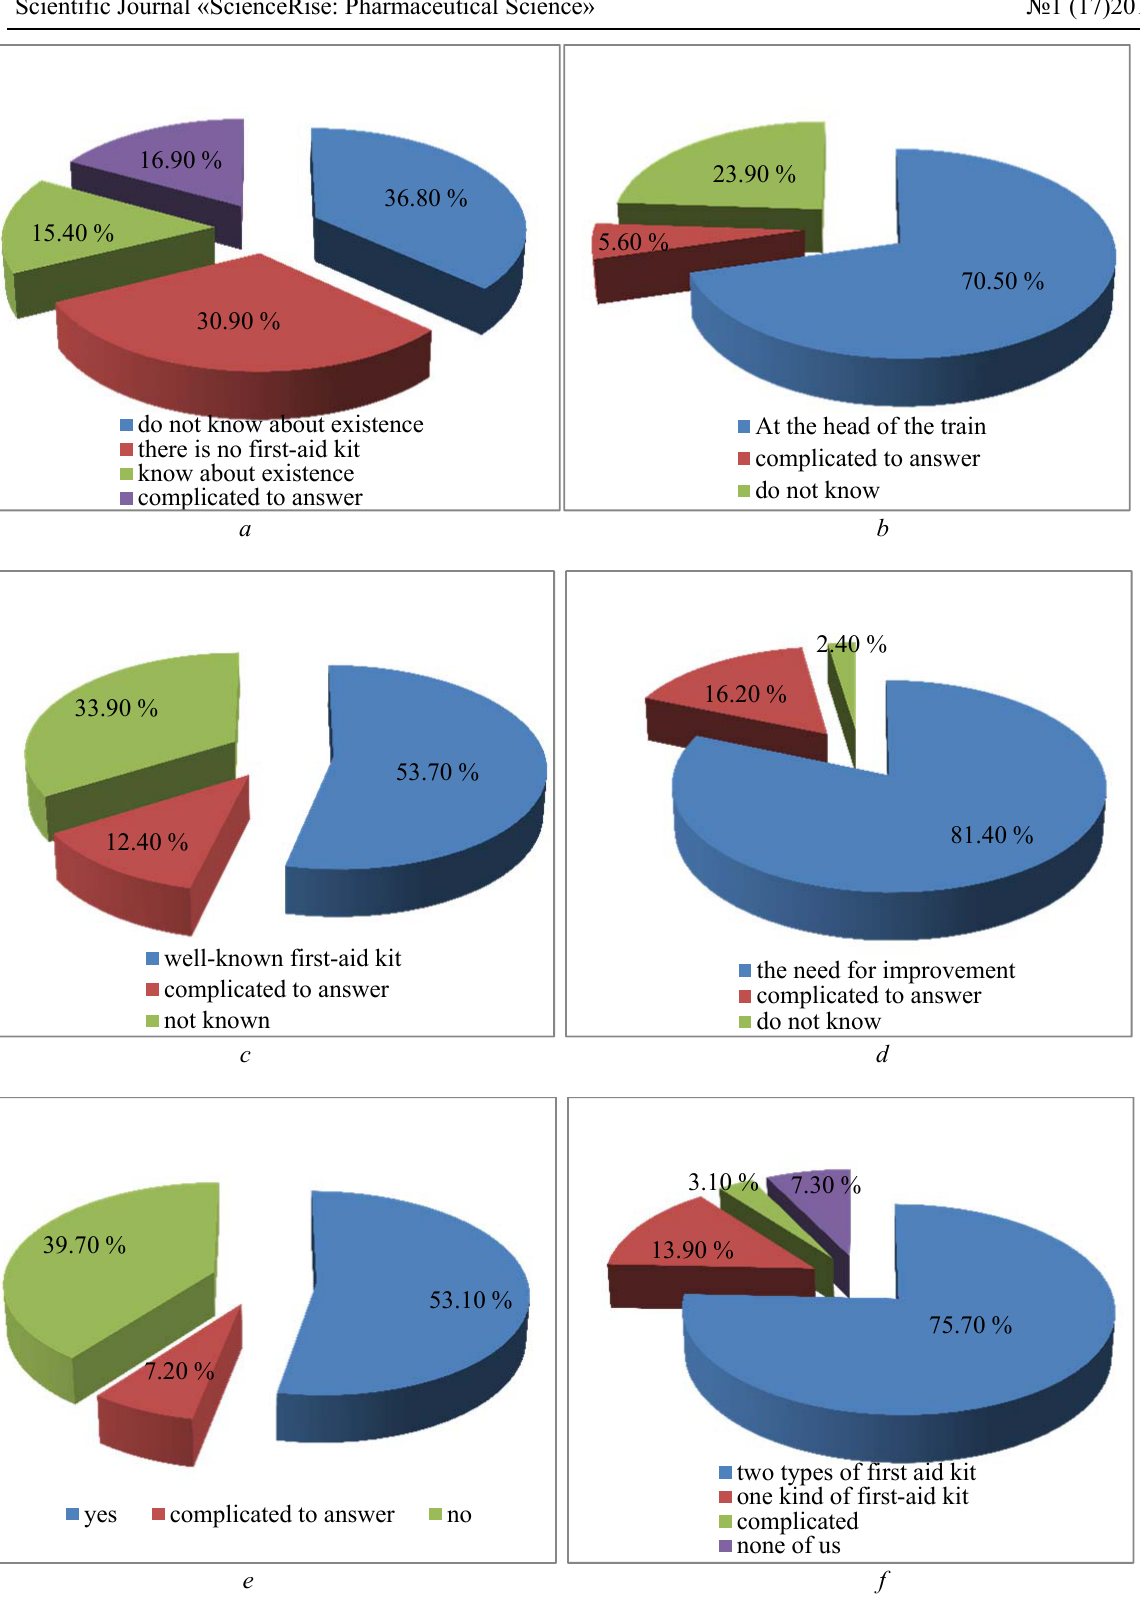
Fig. 4. The results of the expert survey conducted by railway workers on the provision of trains with medical first aid kits: a – availability of medical first-aid kit; b – the medical first-aid kit location; c – respondents are well-known for the medical first-aid kit; d – perfection of the medical first-aid kit; e – passing training in medical care; f – optimal